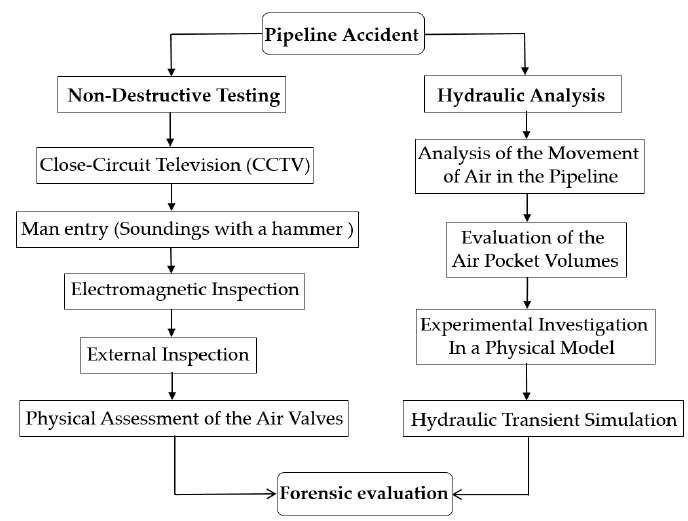
Figure 2. Investigations and simulations developed to identify the causes of the incident.